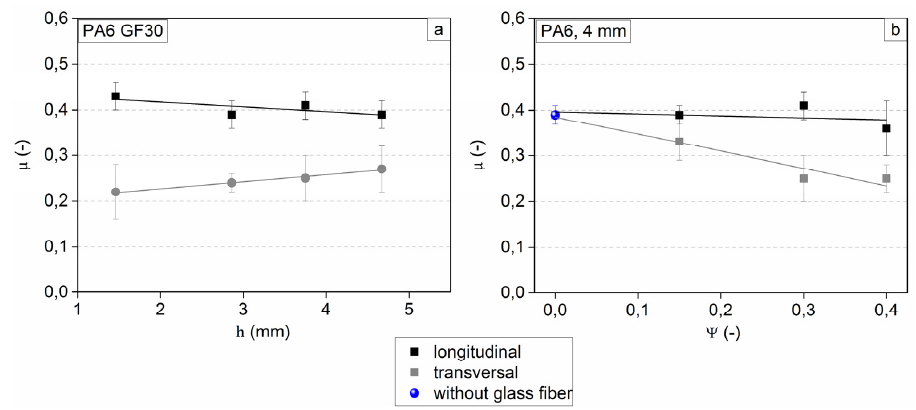
Figure 5. Poisson’s ratio as a function of ( a ) specimen thickness with glass fiber orientation longitudinal and transverse; ( b ) glass fiber content at 4 mm thickness.